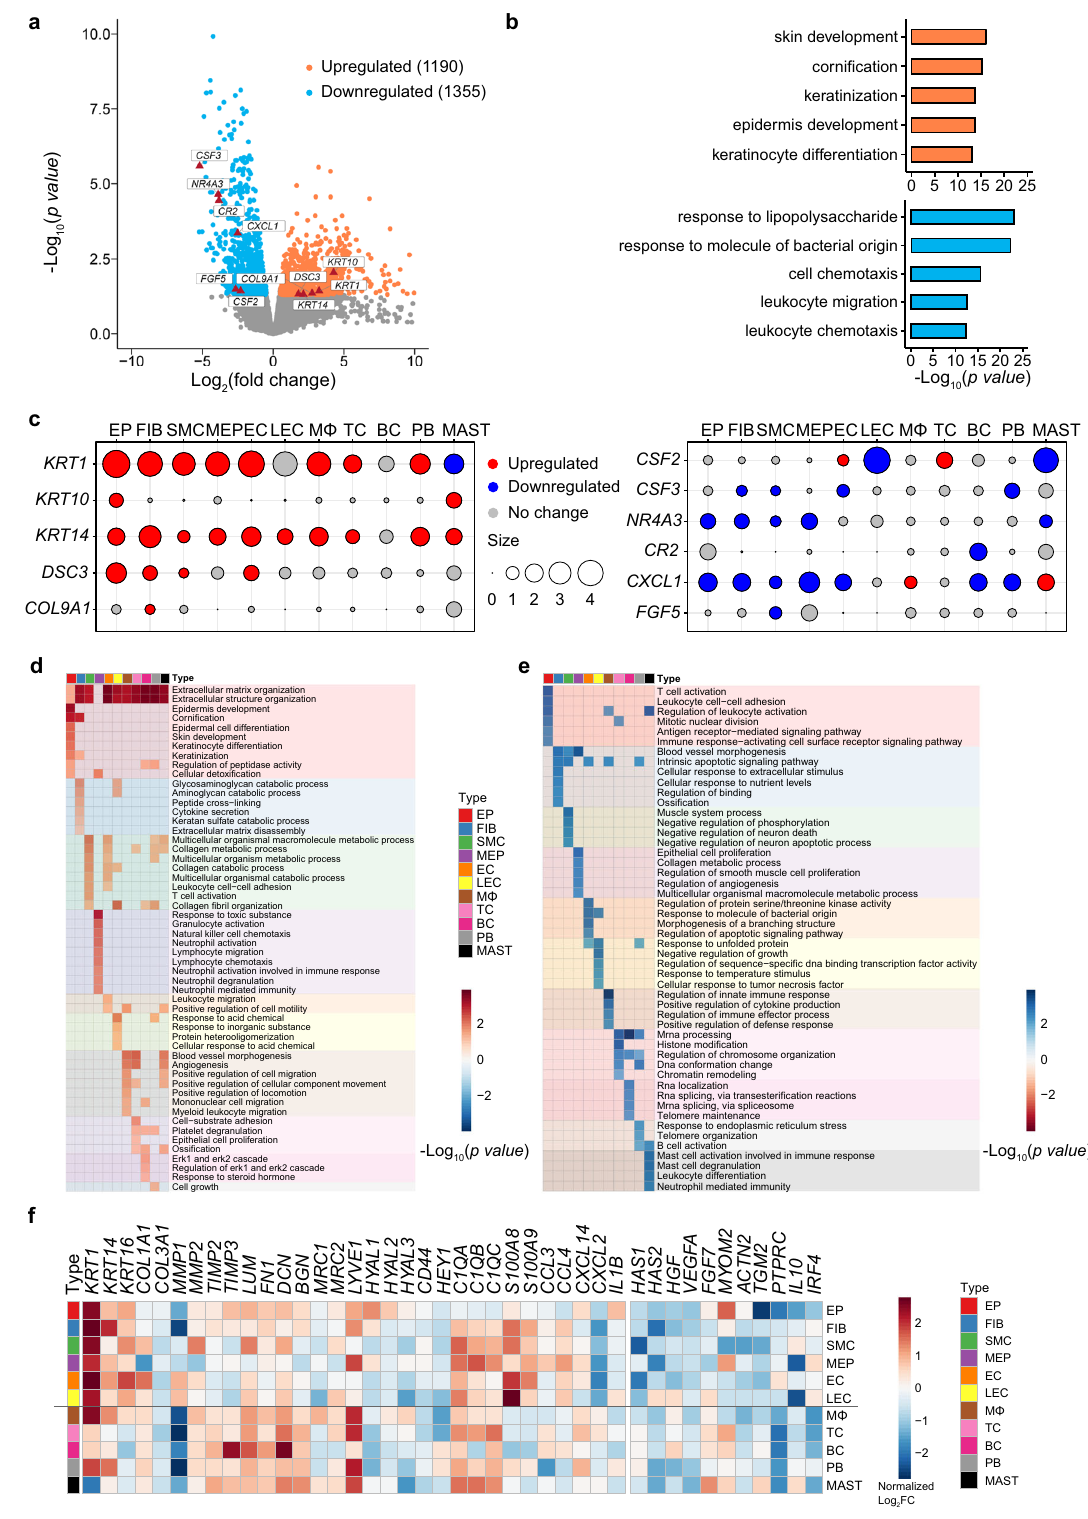
enriched in upregulated genes in smooth muscle cells from